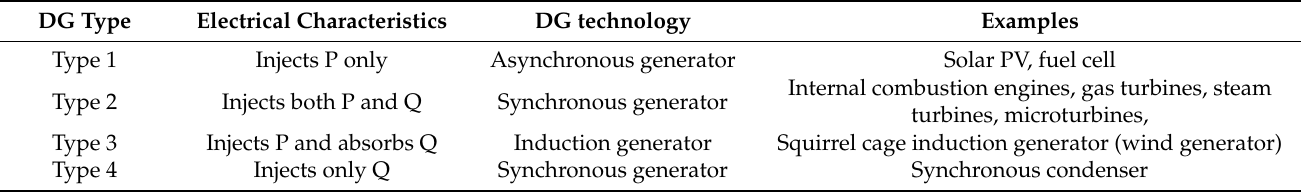
Table 2. DG Technology Types and Classes [41].